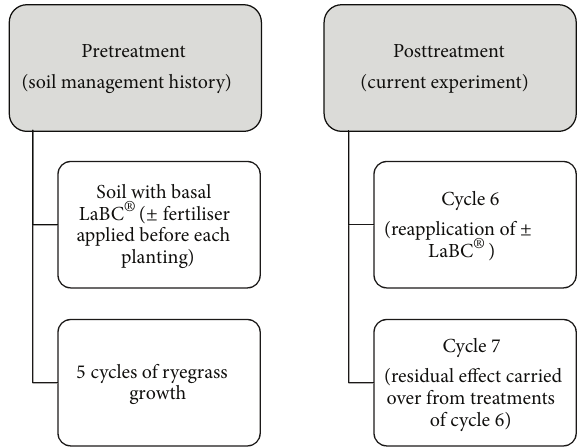
Figure 1: Steps involved in determining the residual effect of LaBC Ⓡ in either the presence or absence of added fertilizer. Dry LaBC Ⓡ = 50 tha −1 of wet weight equivalent; fertiliser = macronutrient fertilis- ers (N, P, K, Ca, and Mg) applied according to district